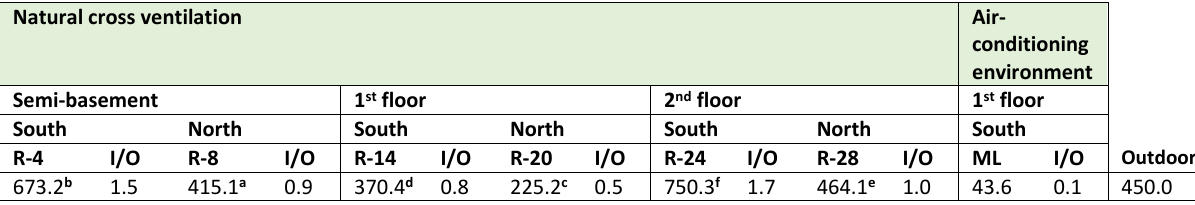
TABLE 1. Fungal concentrations (CFU m -3 ) registered in the indoor and outdoor environments and the obtained indoor/outdoor ratios